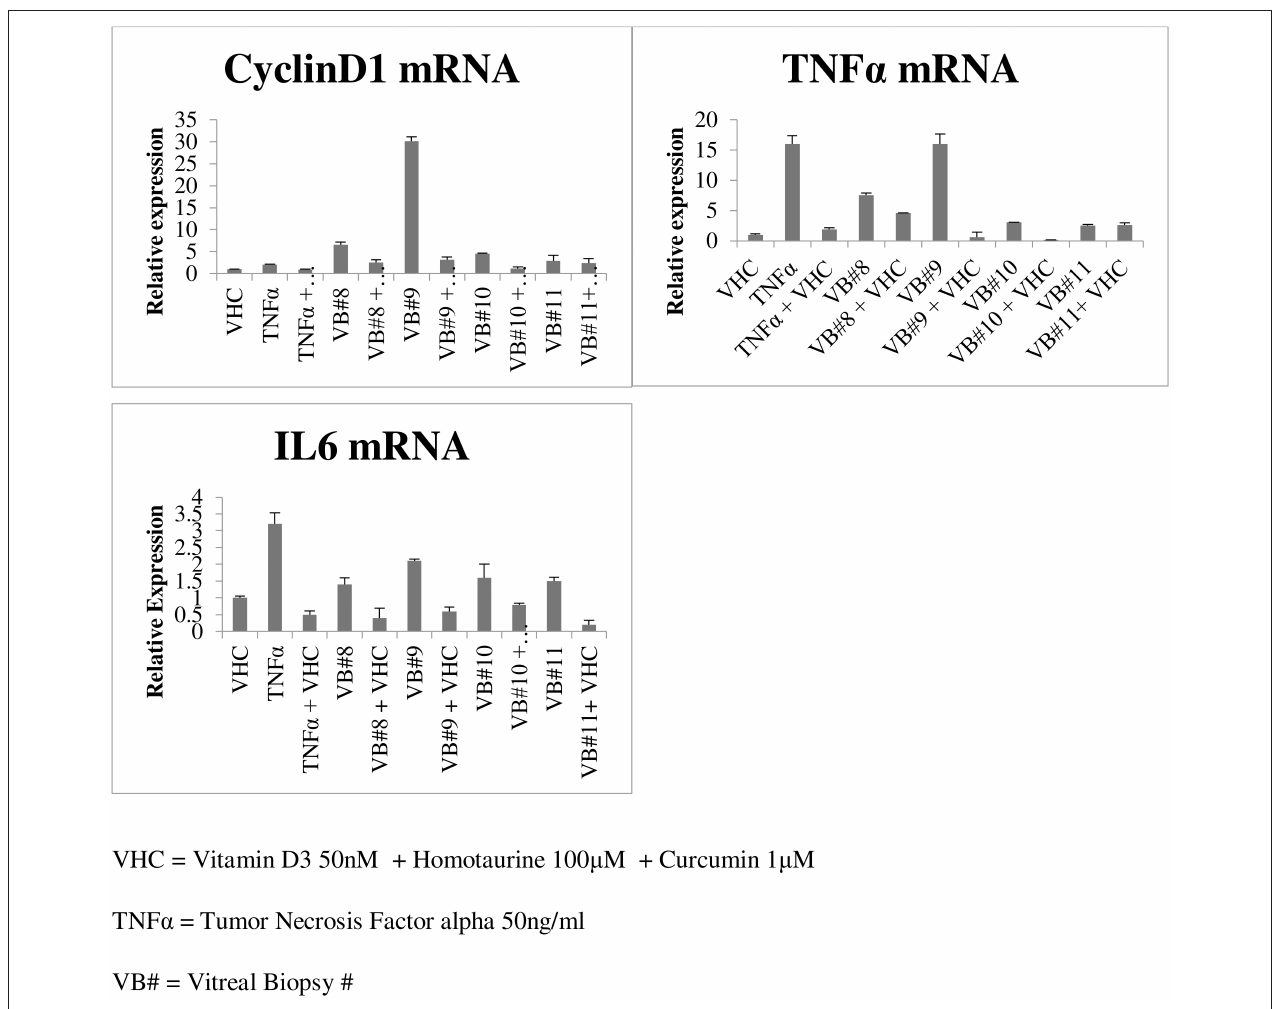
FIGURE 5 | Gene expression in the vitreous of diabetic retinopathy